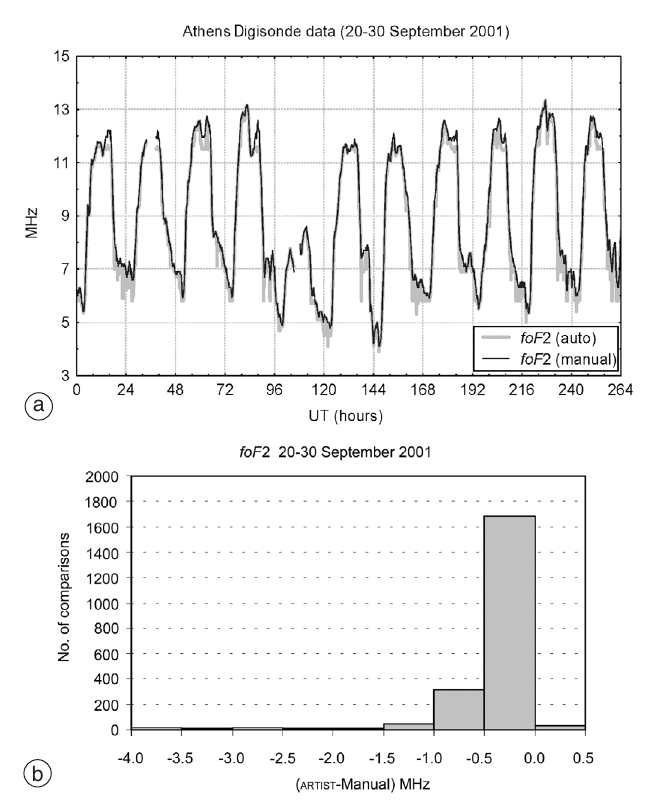
Fig. 2a,b. a) Comparison of automatic scaled (gray line) and manually scaled validated (black line) foF 2 from Athens Digisonde station for a time period of 11 days. b) Differences between the values of foF 2, as scaled by ARTIST and by manual method from 2019 ionograms recorded at Athens during the period 20-30 September